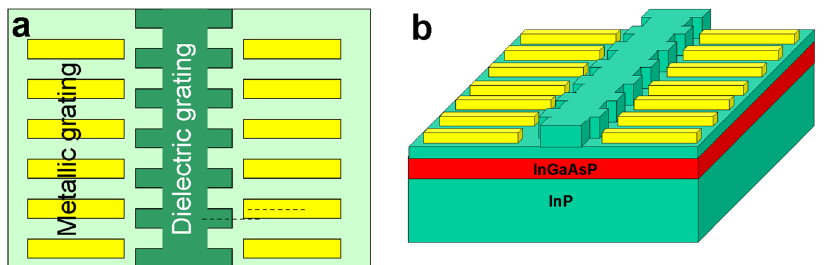
Figure 1: a) Principle of parity-time (PT) symmetric gratings, with symmetry planes of gratings (dashed lines) shifted by a quarter period; b) Implementation using a dedicated waveguide ridge tech- nology. The parity (P) operator corre- sponds to the dielectric grating symmetry plane (lower dashed line) while the time (T) operator fl ips the sign of Im(n) modu- lation versus its nonzero mean